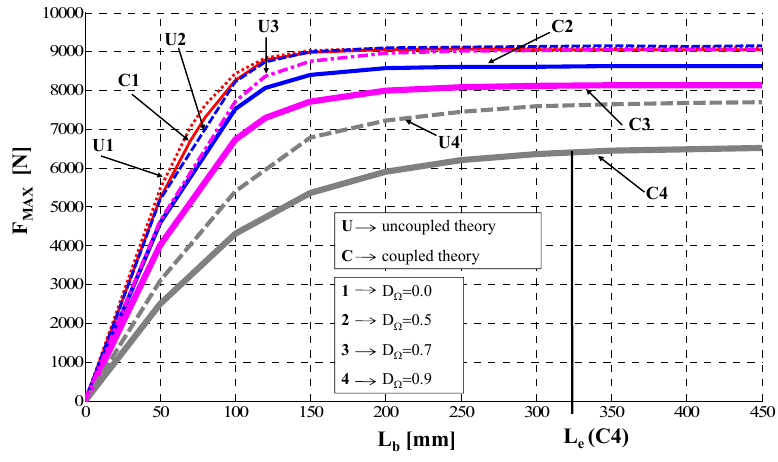
F versus adhesion length max